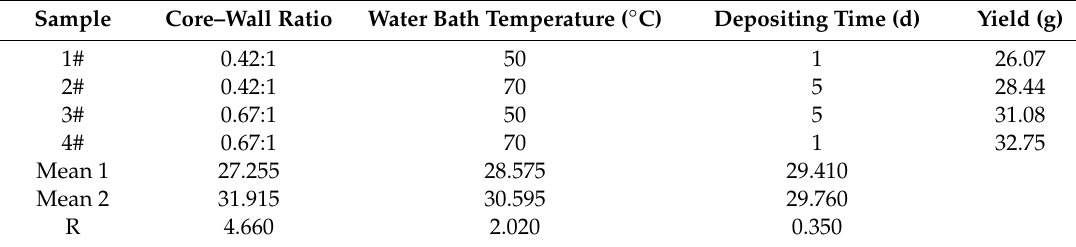
Table 3. Range results of microcapsule yield.